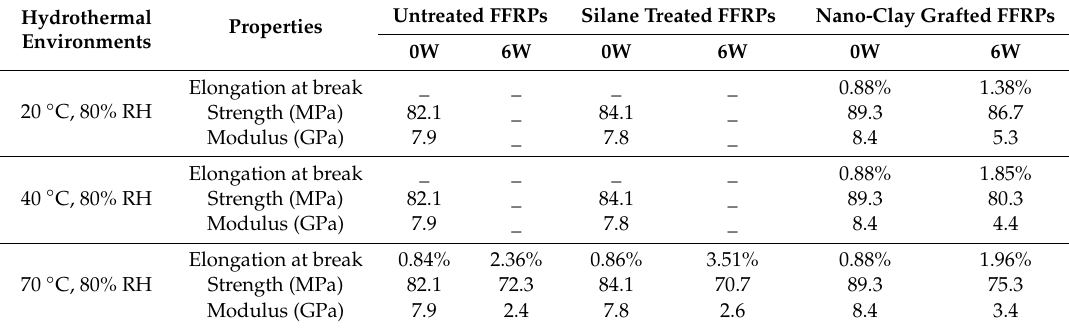
Table 5. Tensile properties of FFRPs.